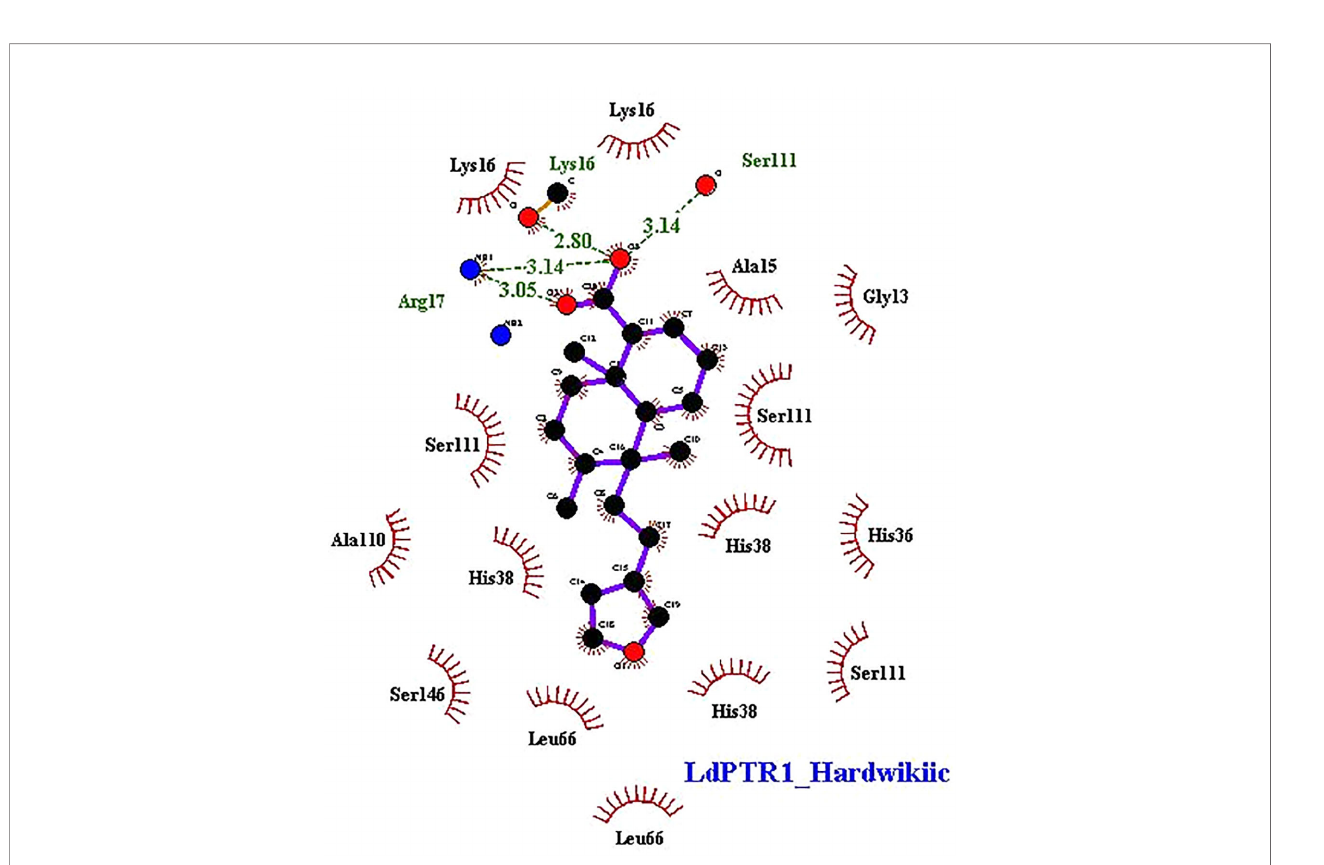
FIGURE 6 | 2D representations of protein-ligand interaction between hardwickiic acid and the receptors Ld PTR1. Hydrogen bonds are denoted as green dash lines while red spike arcs represent hydrophobic